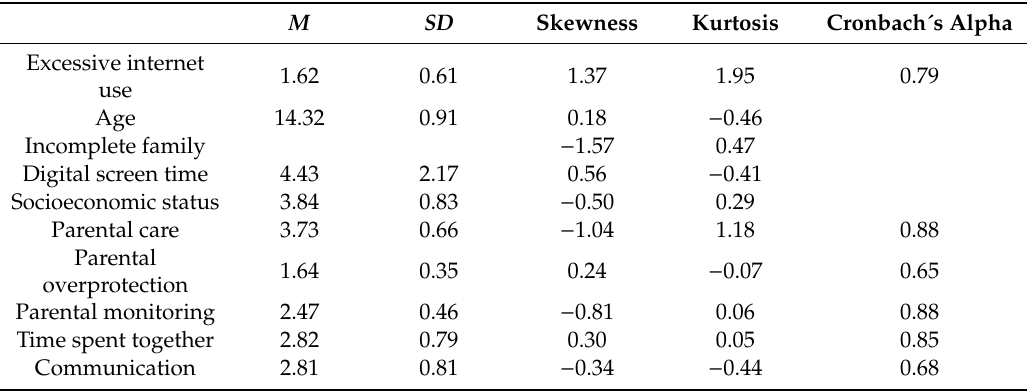
Table 1. Descriptive statistics for study